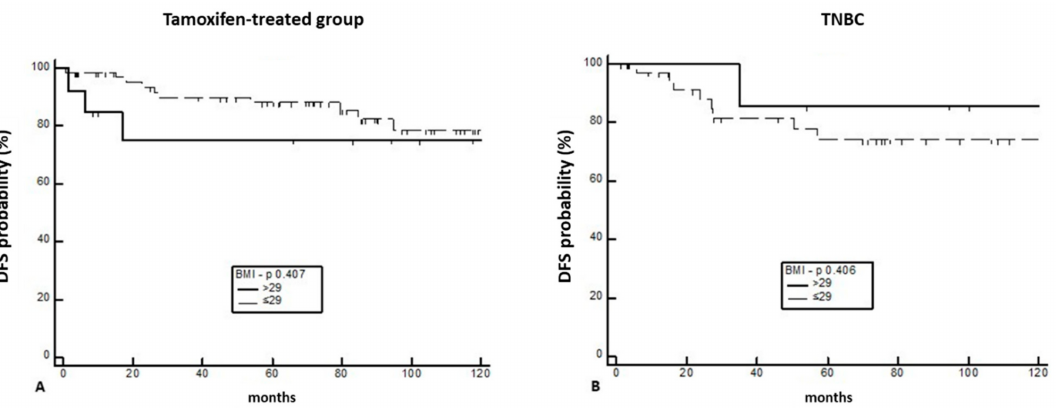
Figure 5. Two-year DFS of BC patients treated with Tamoxifen ( A ) or without endocrine therapy due to TNBC ( B